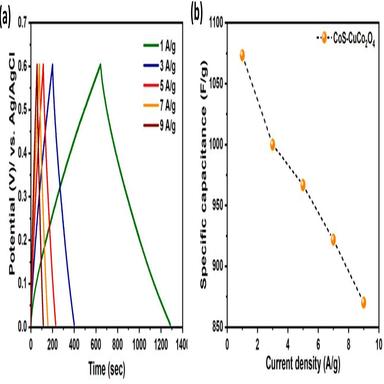
GCD measrements; (a) GCD plots at 1–9 A/g and (b) specific capacitance at 1–9 A/g.